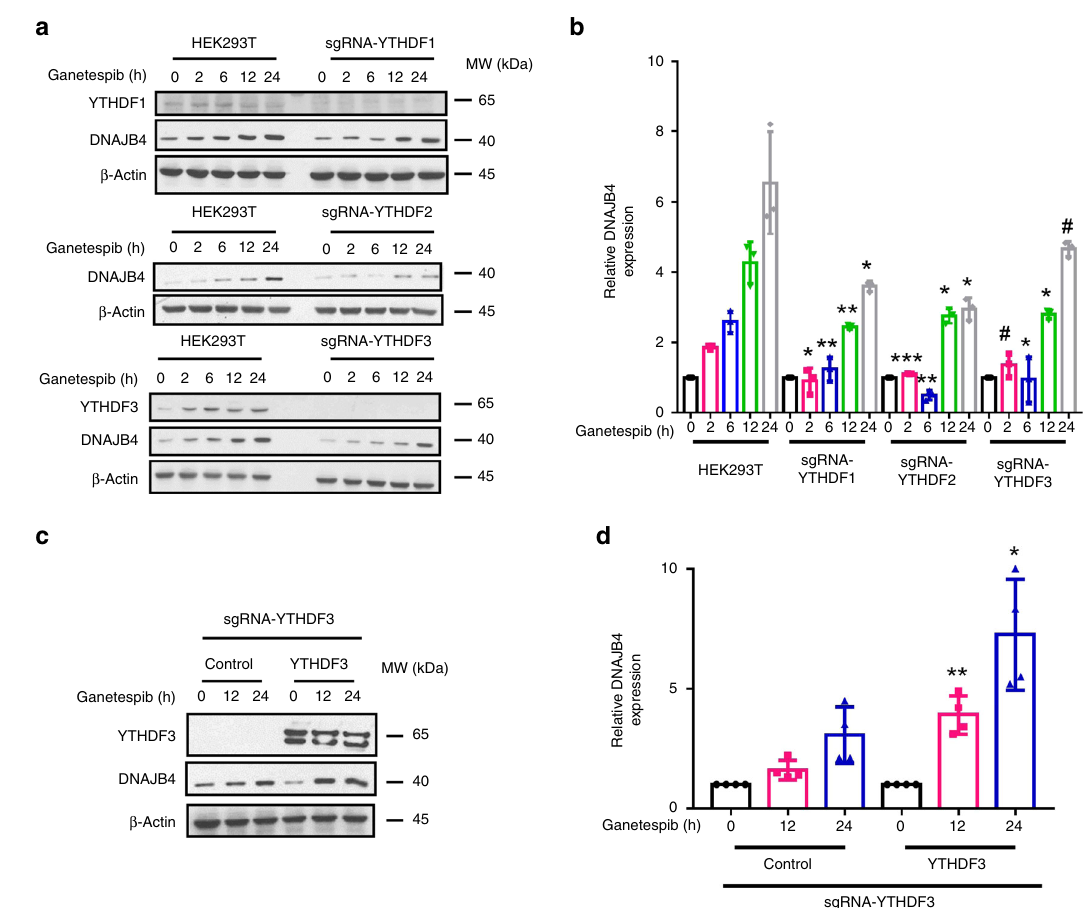
Fig. 5 Modulation of DNAJB4 protein level by m 6 A readers. a Western blot for monitoring the expression levels of DNAJB4 in HEK293T cells or the isogenic cells with the YTHDF1 , YTHDF2 , and YTHDF3 genes being ablated by the CRISPR-Cas9 genome editing method at different time intervals following exposure with 100 nM ganetespib. b Quanti fi cation data based on western blot analysis in ( a ). c Western blot for monitoring the expression levels of DNAJB4 in YTHDF3-de fi cient HEK293T cells complemented with an empty pRK7 plasmid (control) or pRK7-YTHDF3 at different time points following exposure to 100 nM ganetespib. d Quanti fi cation data based on western blot analysis in ( c ). β -actin was employed as the loading control in ( a ) and ( c ). Shown in ( b ) and ( d ) are the ratios of expression of DNAJB4 protein over β -actin, and further normalized to the ratios obtained for the control cells without ganetespib treatment. The quanti fi cation data in ( b ) and ( d ) represent the mean ± S.D. of results from three and four independent experiments, respectively. The p- values referred to comparisons between HEK293T cells and the isogenic cells with YTHDF1/2/3 genes being individually ablated ( b ), or between complementation with control and YTHDF3 plasmid ( d ). The p- values were calculated using unpaired, two-tailed Student ’ s t -test: # p > 0.05; *, 0.01 ≤ p < 0.05; **, 0.001 ≤ p < 0.01; ***, p < 0.001. Source data are provided as a Source Data fi